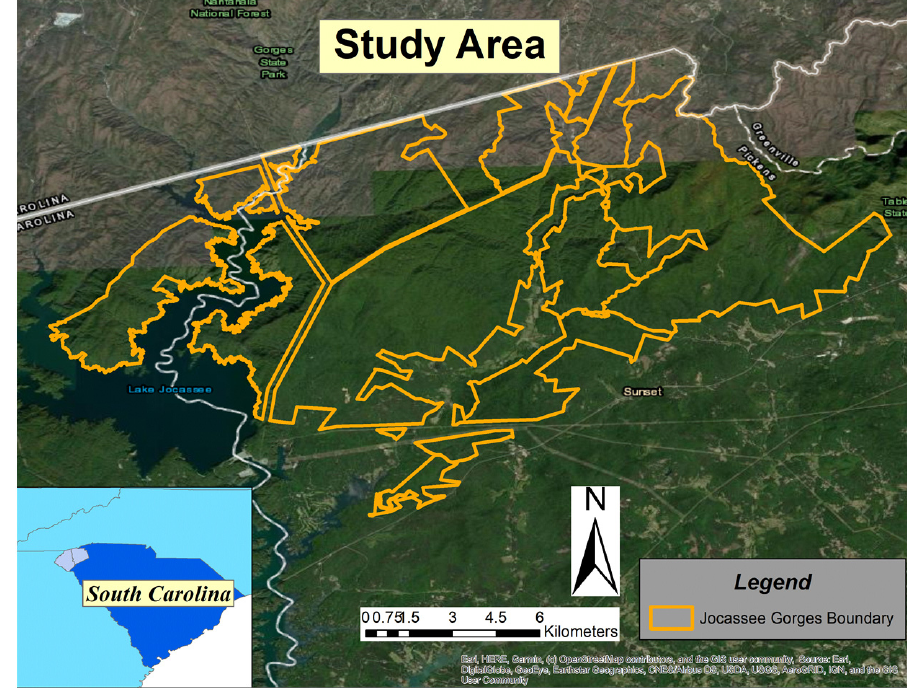
Figure 2. Location of the study area in Pickens and Oconee Counties, SC (34.944530, − 82.918152).